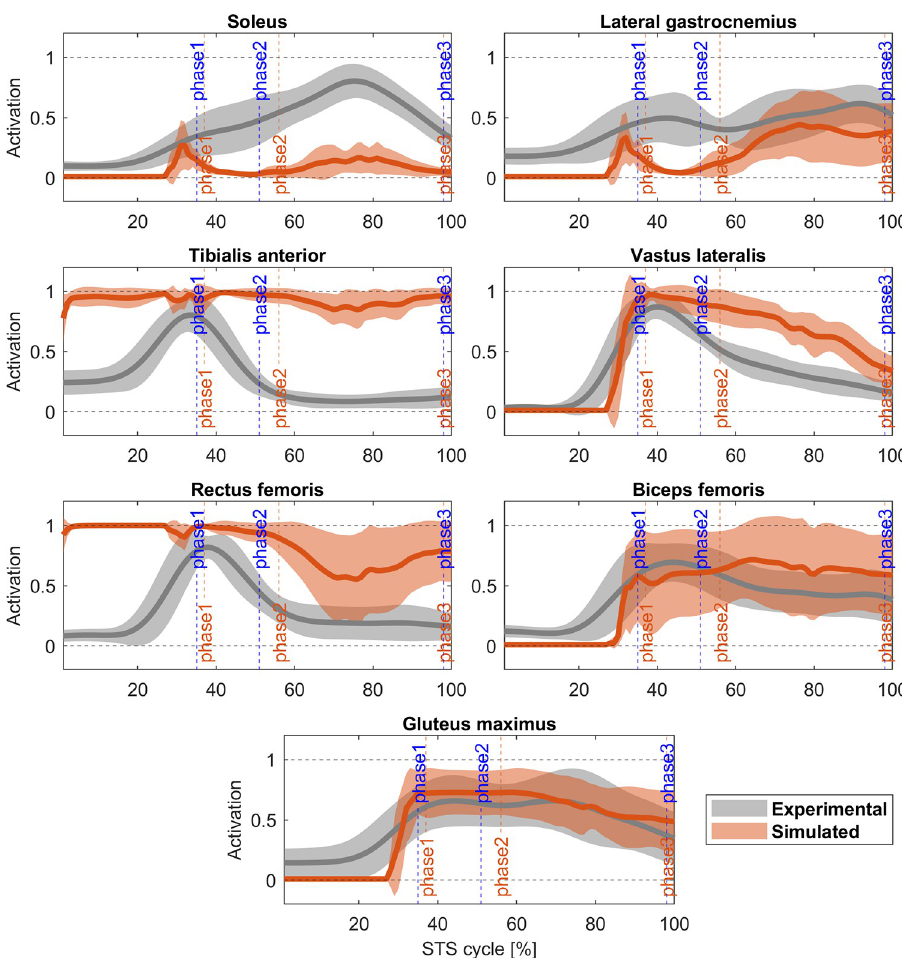
Fig 8. Experimental (grey) and 2-phases controller (orange) muscle activation comparison (mean ± std). Activations is normalized between 0.1 (tonic activation) and 1. Blue vertical lines: experimental cycle times; orange vertical lines: 2-phases controller cycle times. Cross-correlation coefficient: r(SOL) = 0.65 ( Δ = 0%), r(GAS) = 0.79 ( Δ = 0%), r(TA) = 0.58 ( Δ = 11%), r(VAS) = 0.85 ( Δ = 3%), r(RF) = 0.48 ( Δ = -18%), r(BF) = 0.83 ( Δ = 3%), r(GLU) = 0.96 ( Δ =